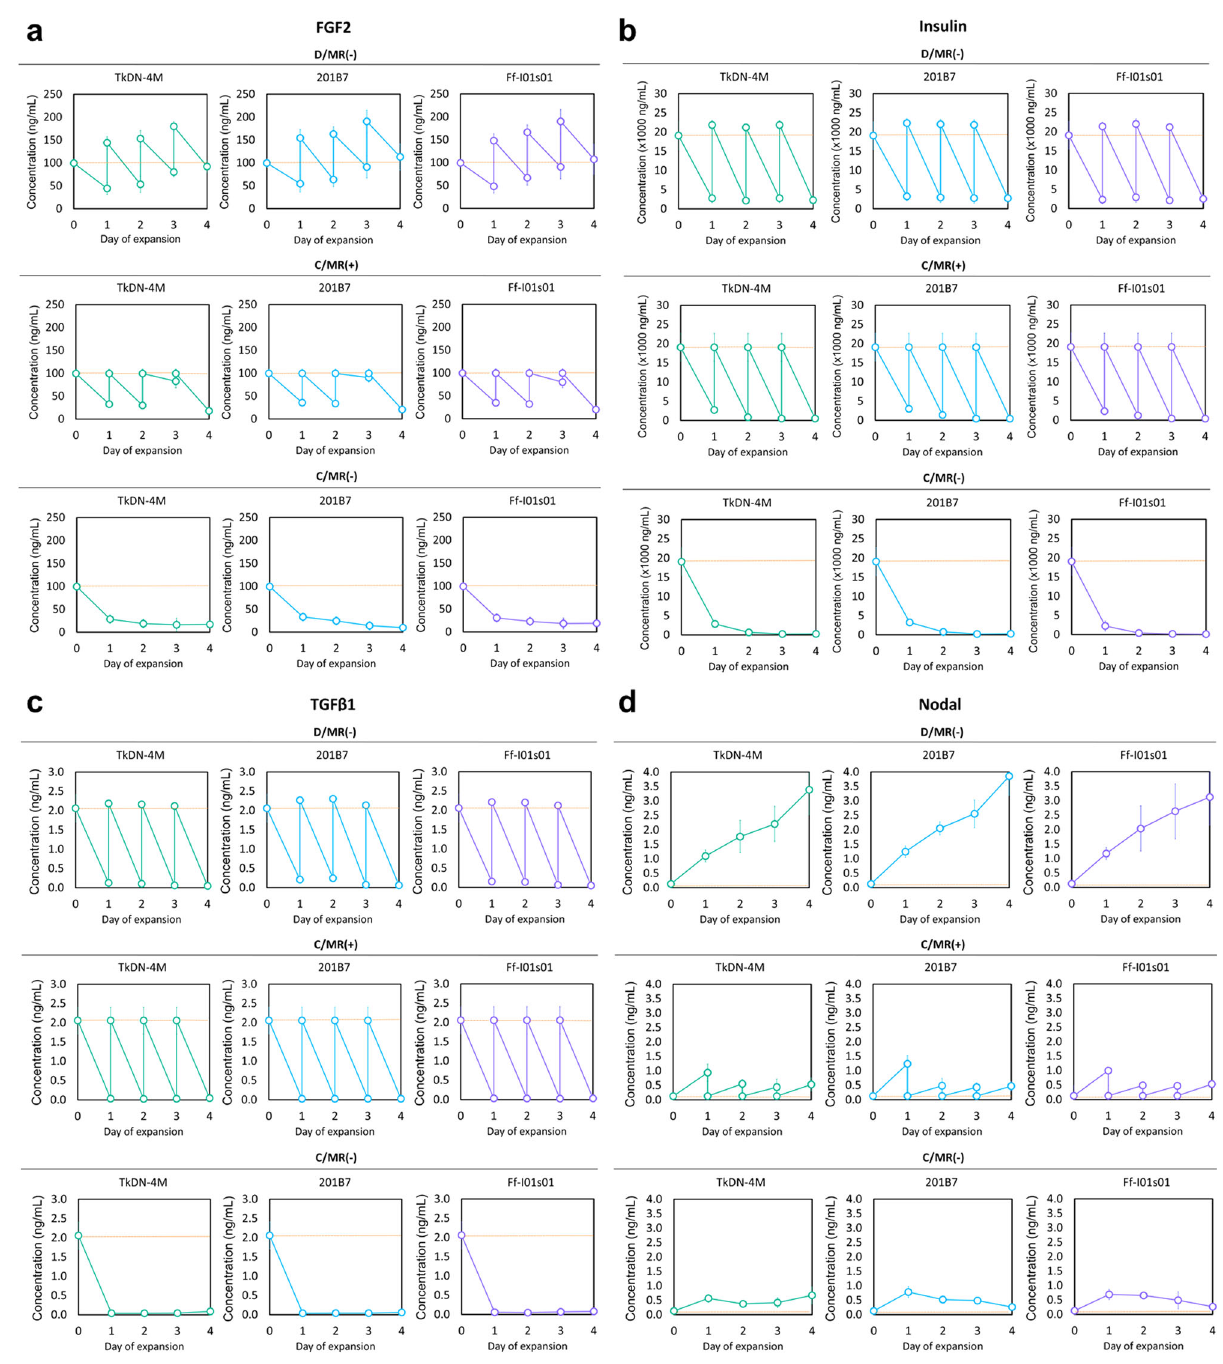
Fig. 4 The mean concentration of the essential growth factors for maintaining pluripotency in culture compartment during hiPSCs expansion. The two main growth factors, a FGF2 and b insulin were well accumulated during the expansion period with D/MR( − ) support. c Although the TGF β -1 only accumulated in a low concentration. d The endogenous Nodal was able to accumulate and potentially reconstitute the insuf fi ciency of TGF β -1 in maintaining the pluripotency. Growth-factor concentration in the culture medium is indicated by the red dotted line. (D/MR( – ) and C/MR( + ): n = 3 biologically independent experiments during fi ve passages; C/MR( − ): n = 3 biologically independent experiments during one passage). Mean ± standard deviation are indicated in each